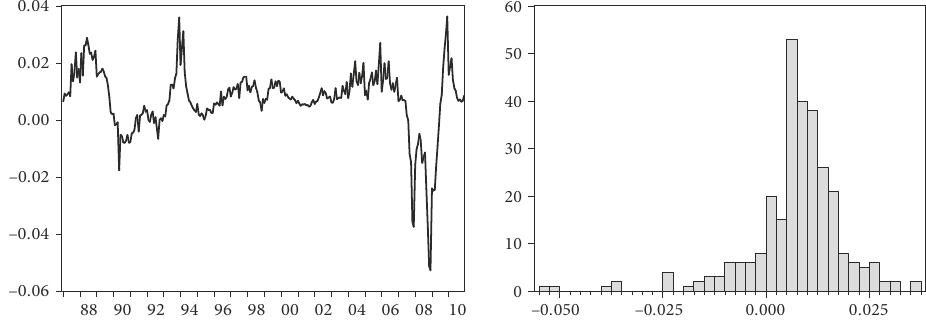
Figure 1. Temporal evolution of the returns of the IPD series and histogram